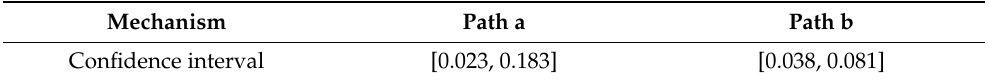
Table 12. Bootstrap